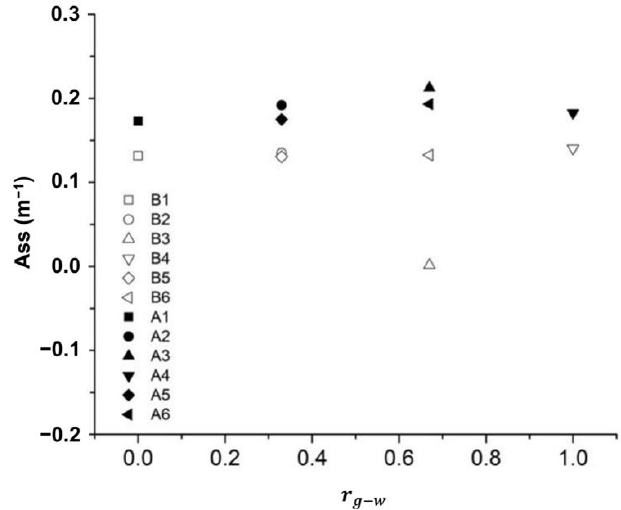
Figure 12. Specific surface area of flooded channels for twelve cases.